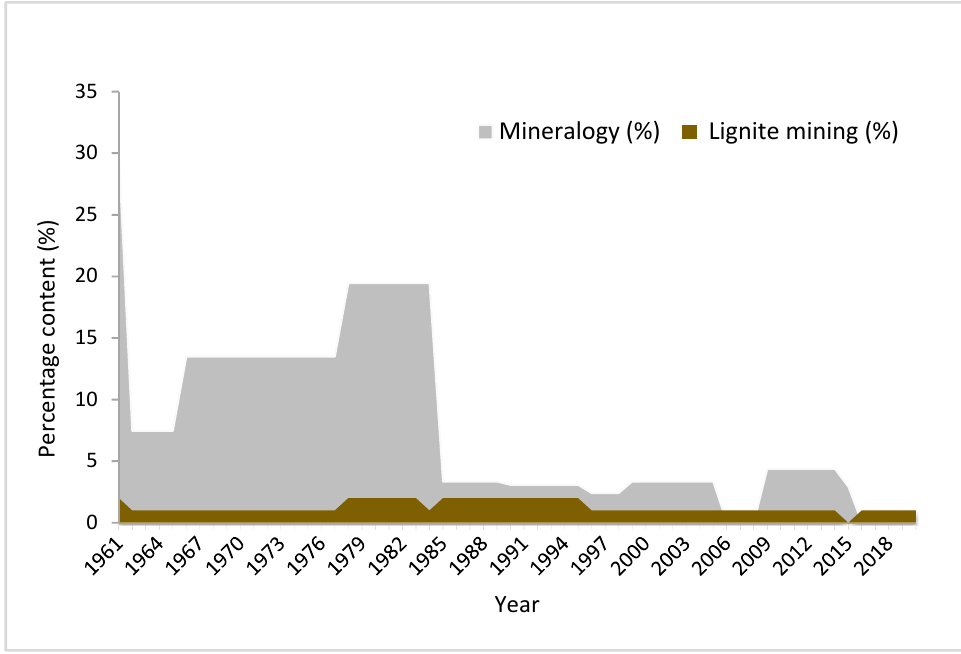
Figure 3. Content (%) of mineralogy and lignite mining in the geosciences textbooks.